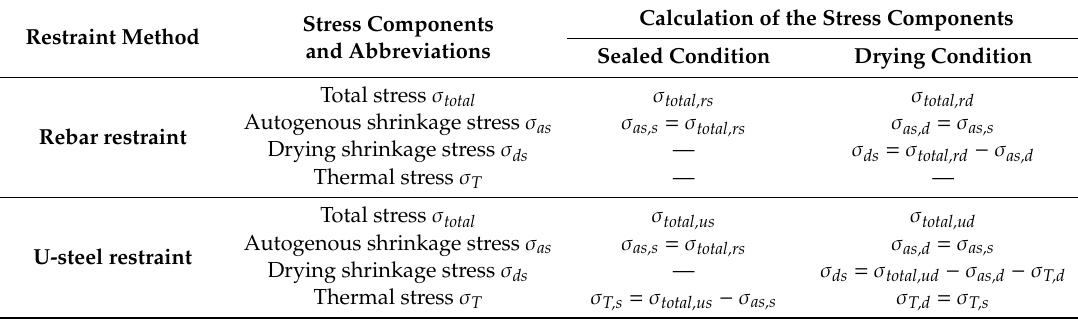
Table 3. Separation of the restraint stresses.